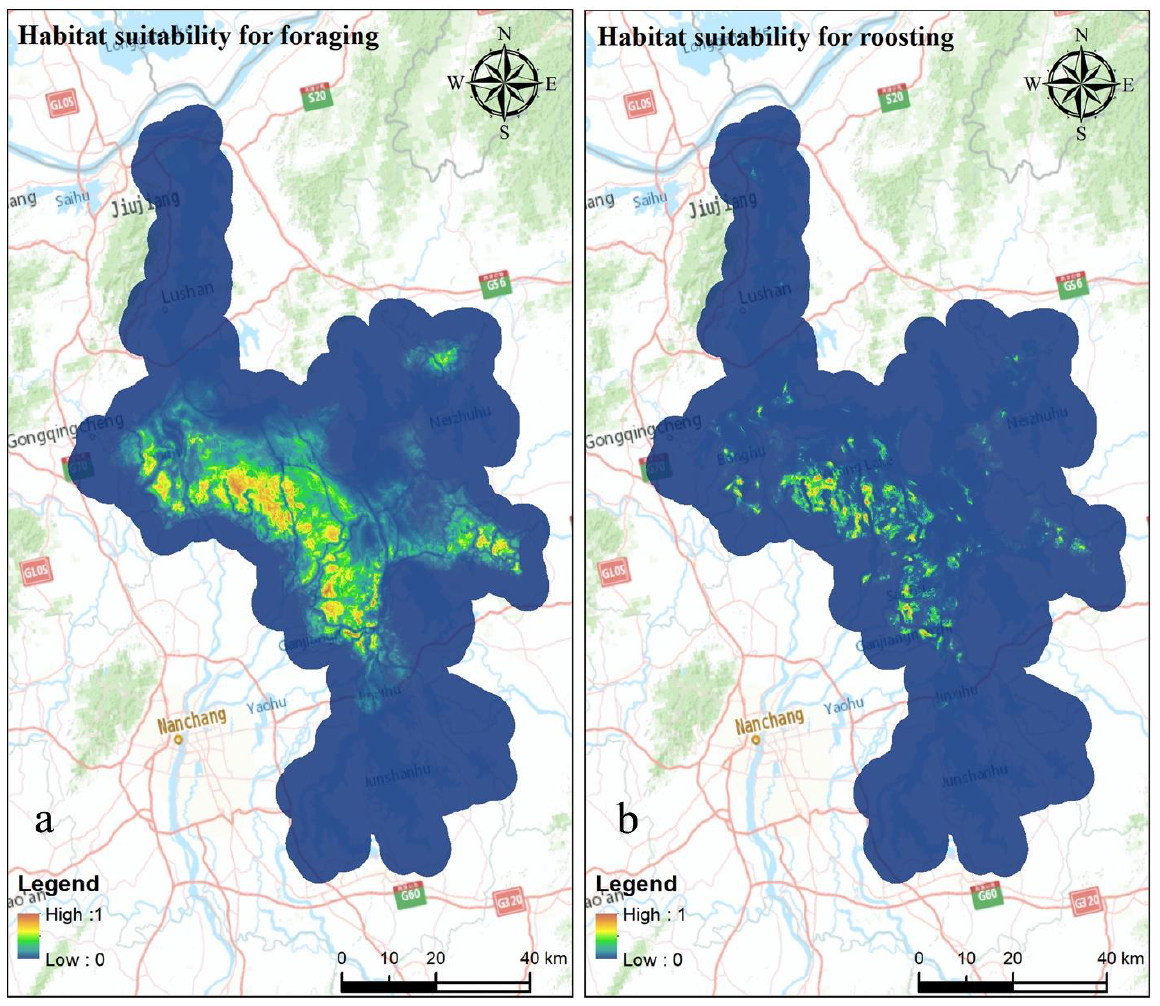
Figure 7. Habitat suitability map generated by scale-optimized variables: ( a ) habitat suitability for foraging and ( b ) habitat suitability for roosting.